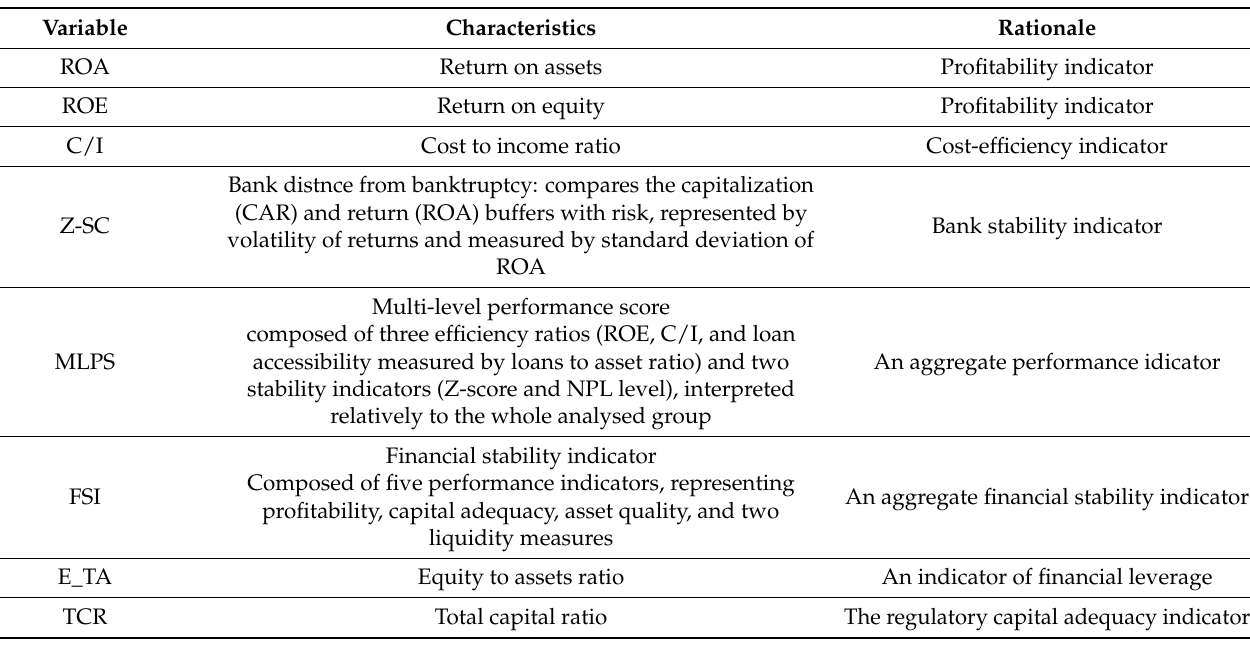
Table 4. Dependent variables.